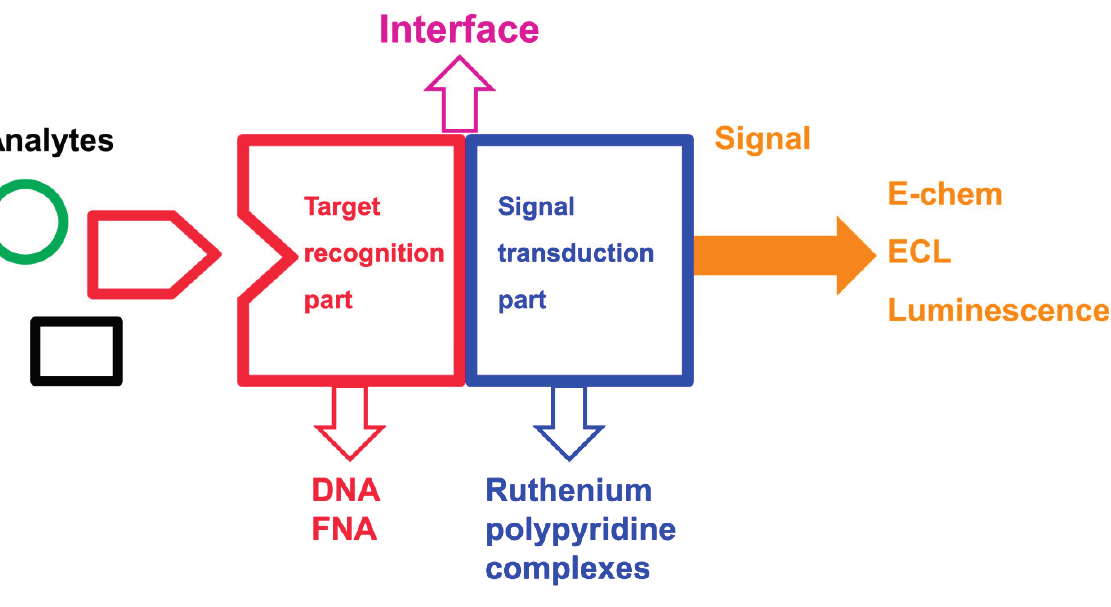
Figure 1. Bioanalytical platform using ruthenium polypyridine complexes (and analogues) as signal transduction elements and oligonucleotides as target recognition